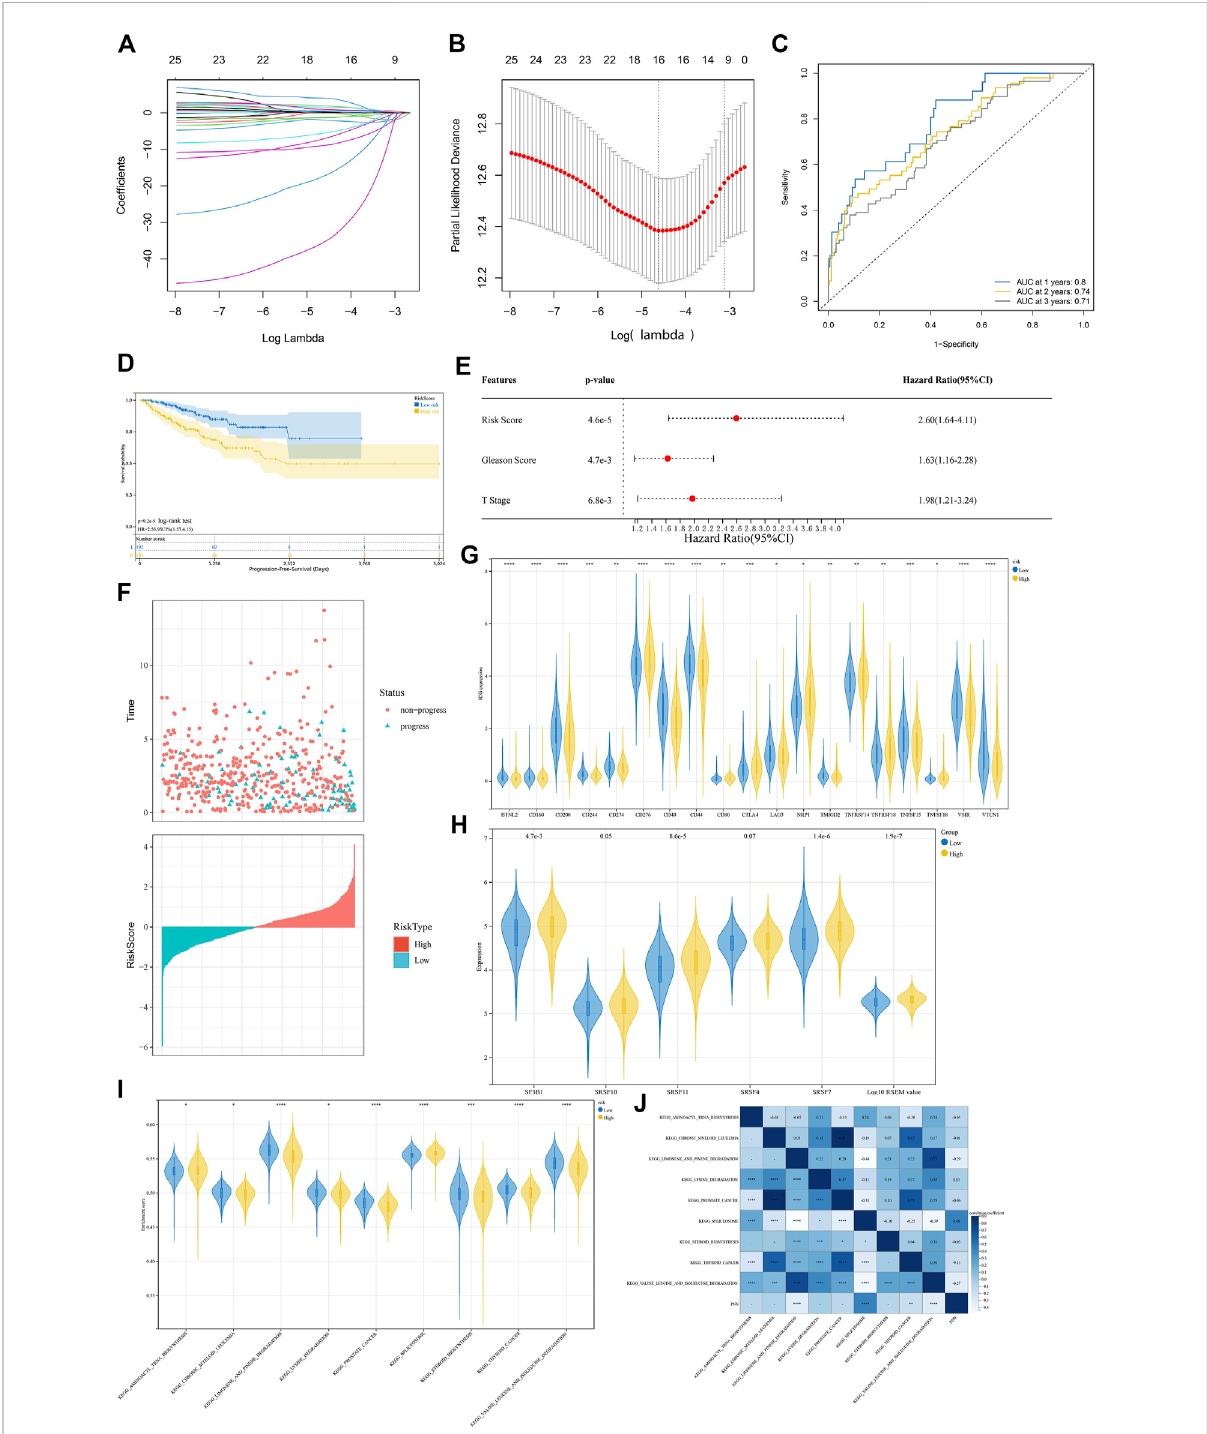
FIGURE 6 Analysis of DNA methylation levels concerning the PNN expression. (A) LASSO model tuning parameters ( λ , lambda) were selected by 10-fold cross-validation. (B) LASSO coef fi cient pro fi les of 180 CpG sites. (C) ROC Curves of the risk model performed in the TCGA-PRAD cohort ’ s CpG sites methylation data. ROC, receiver operating characteristics. (D) Kaplan Meier (KM) plot for a discriminative median patient risk score with two methylation sites about PFS. (E) Hazard ratio and p -value of constituents involved in multivariate Cox regression and some parameters of the CpG-site signature. (F) The distribution of the PFS status of patients in the high-risk and low-risk groups. (G) Different levels of each immune checkpoint (Danilova et al., 2019) between high and low-risk groups using violin plots and the Wilcoxon test. * p < 0.05; ** p < 0.01; *** p < 0.001;